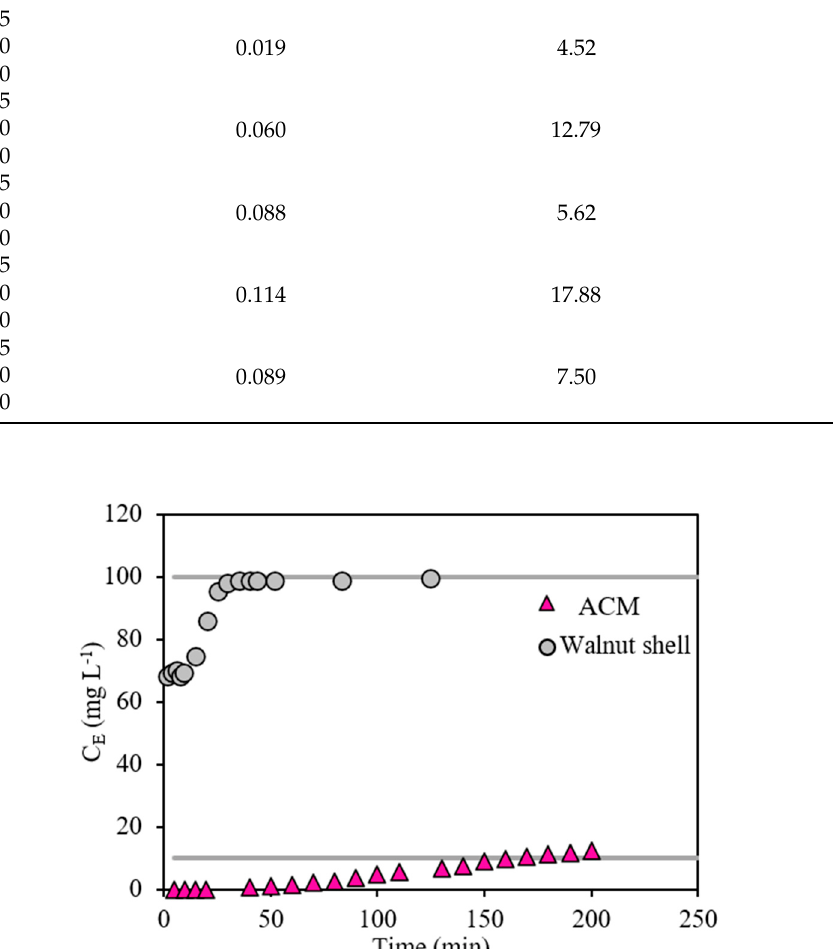
Table 5. Thermodynamic parameters for the adsorption of crude oil in oil-in-water emulsions, for activated carbon modified with 5.0 wt.% of magnetite nanoparticles (ACM), the synthesized activated carbon (AC), The pyrolyzed coffee residue (PCR), coffee residue (CR), and Walnut shell (WH), for temperatures of 25 ◦ C, 40 ◦ C and 50 ◦ C. Material